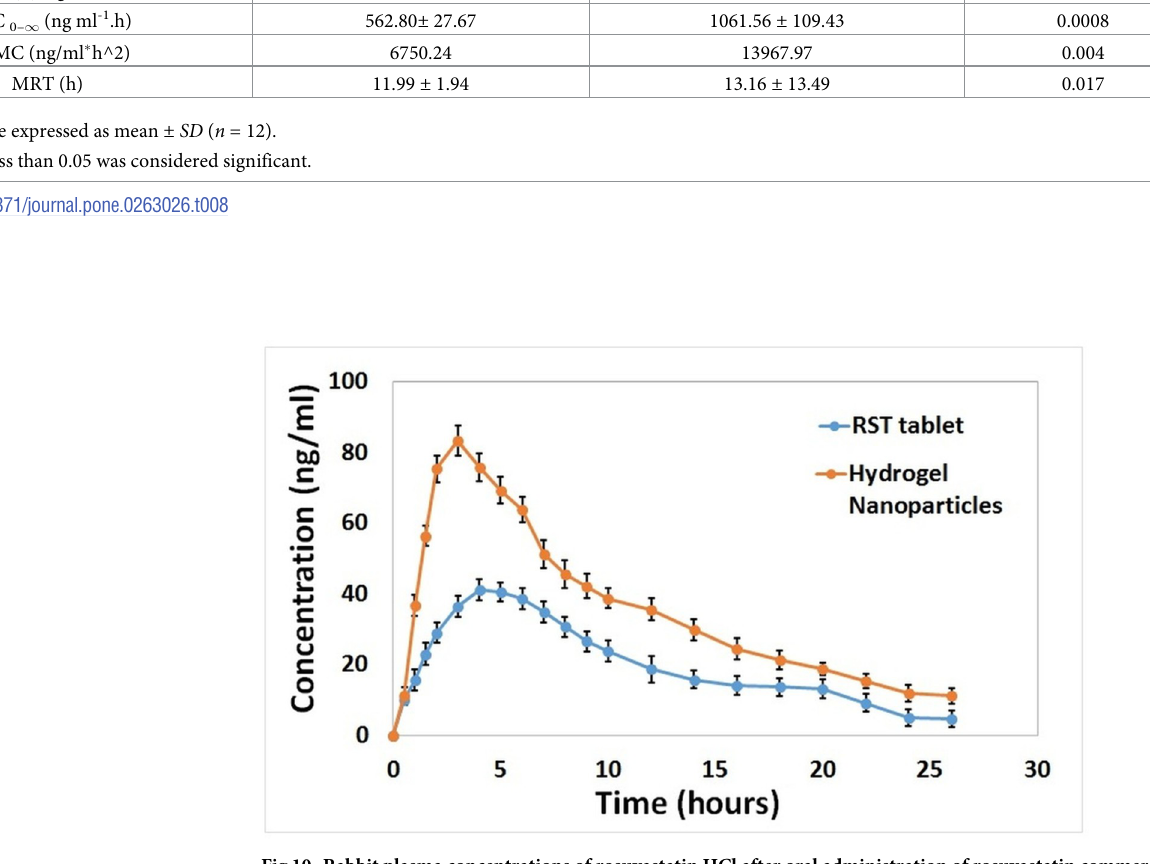
Fig 10. Rabbit plasma concentrations of rosuvastatin HCl after oral administration of rosuvastatin commercially available tablets and loaded nanogels showing better bioavailability of